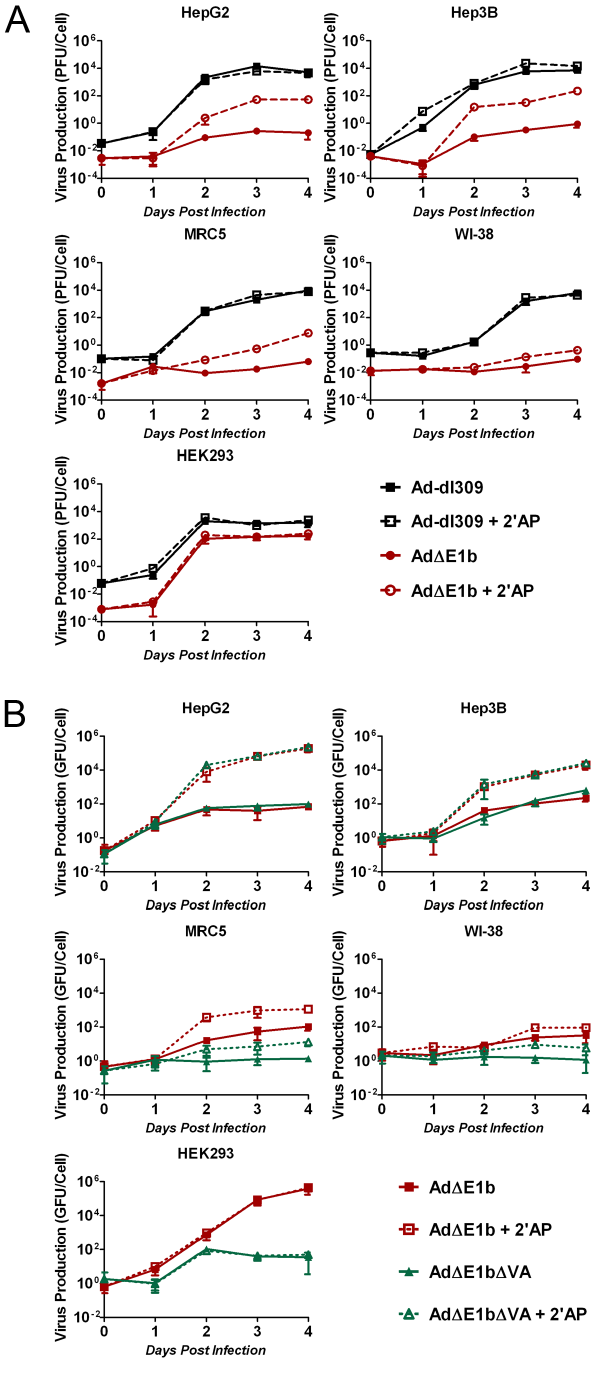
Figure 2. 2 9 AP increases the replication of an adenovirus with an E1b-55K deletion but not with a VA-RNA deletion. Cells were infected in duplicate with (A) Ad-dl309 D VA, (B) Ad-dl1520, or (A and B) Ad-dl309 at a multiplicity of infection (MOI) of 1 plaque forming unit per cell (PFU/cell) 1 hour prior to treatment with medium containing no drug or 2.5 mM 2 9 AP. Cells and media were harvested at 1 hr (day 0) as well as 1, 2, 3 and 4 days post-infection. Virus yields were determined using plaques assays on HEK293 cells. Error bars correspond to + / 2 SD.